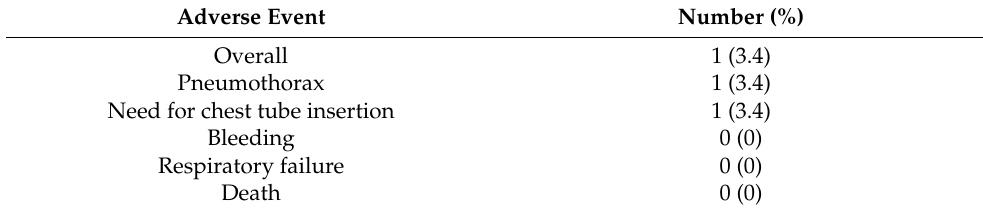
Table 4. Safety profile of